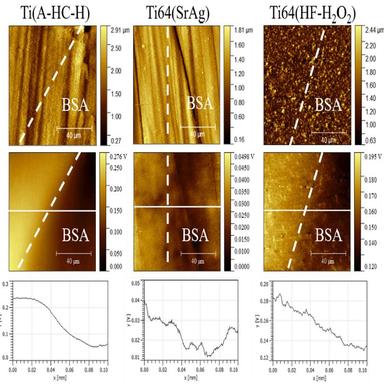
KPFM images of samples after albumin adsorption on a portion of the surface: topographical image (first row); surface potential image (second row); potential profile along the white line (third row). Dashed lines separate areas without (left of the line) and with (right of the line) albumin layer.